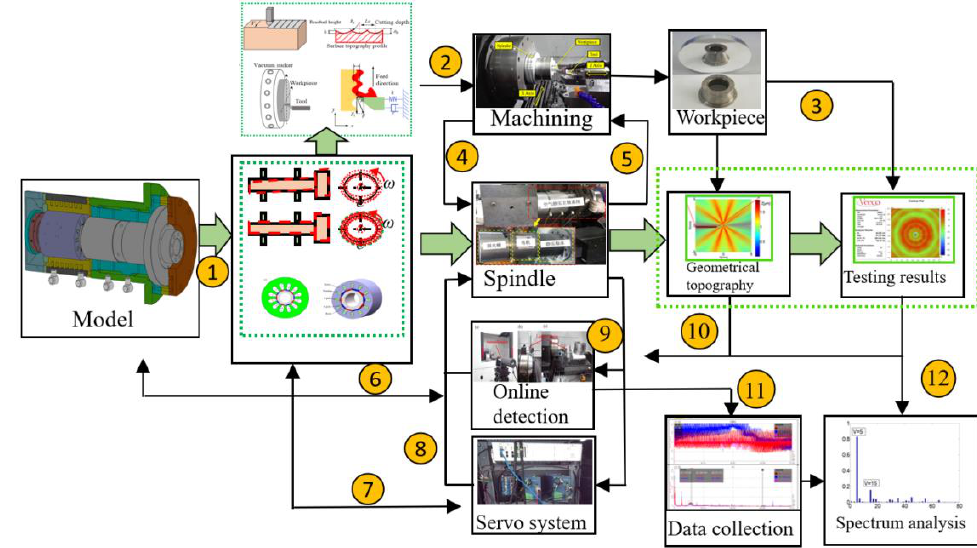
Figure 6. Multi-field coupling analysis and verification process of ultra-precision aerostatic bearing spindle system.